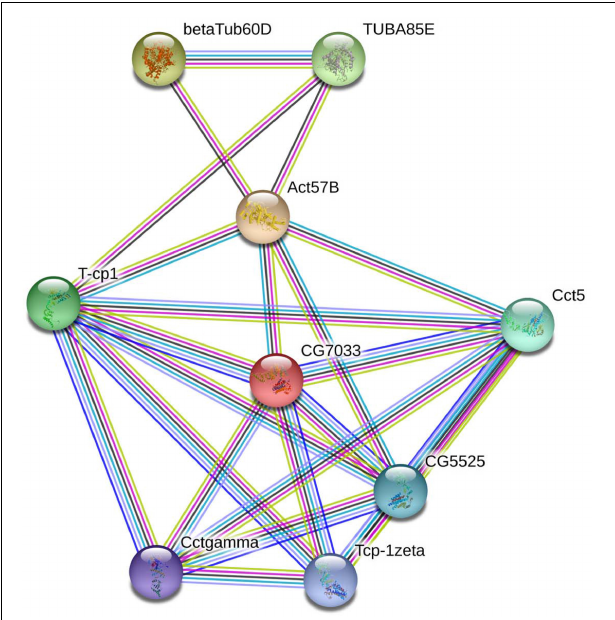
FIGURE 1 | The interaction network of TCP-1 β with selected cytoskeletal proteins was constructed based on the STRING website information using the database of another well-studied insect, D. melanogaster . CG7033, TCP-1 β ; Act57B, actin; β -Tub60D, β -tubulin; TUBAB5E, α